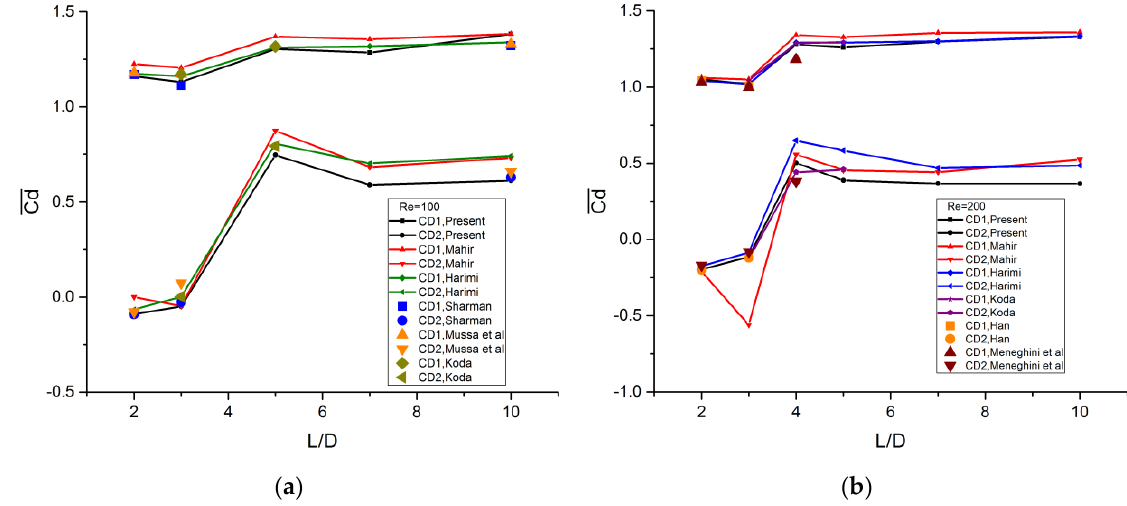
Figure 4. The drag coefficients for a two-cylinder tandem array with different distance ratios, Cd 1 is the drag coefficient for upstream cylinder, Cd 2 is the drag coefficient for downstream cylinder: ( a ) Re = 100; ( b ) Re = 200.